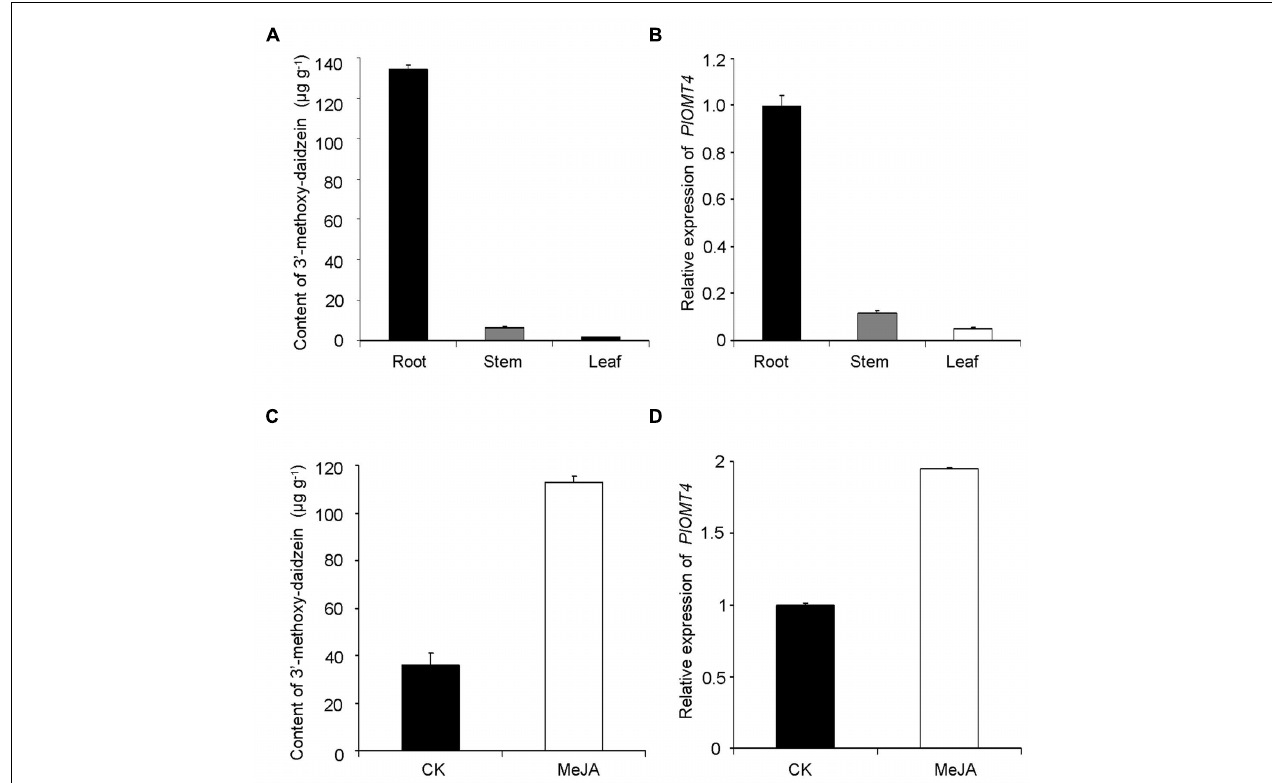
FIGURE 5 | Correlation analysis of the PlOMT4 transcript abundance with the accumulation of the 3 (cid:48) -methoxy-daidzein. (A) , the accumulation pattern of 3 (cid:48) -methoxy-daidzein in the different organs of P. lobata ; (B) , the relative abundance of the PlOMT4 transcript in the different organs; (C) , the increment of the accumulation of the 3 (cid:48) -methoxy-daidzein in the P. lobata roots in response to the MeJA stimuli; (D) , the elevation of the PlOMT4 transcripts in the P. lobata roots by the MeJA treatment. The P. lobata actin gene (GenBank accession no. HO708075) was used as an internal standard for the gene expression analysis.